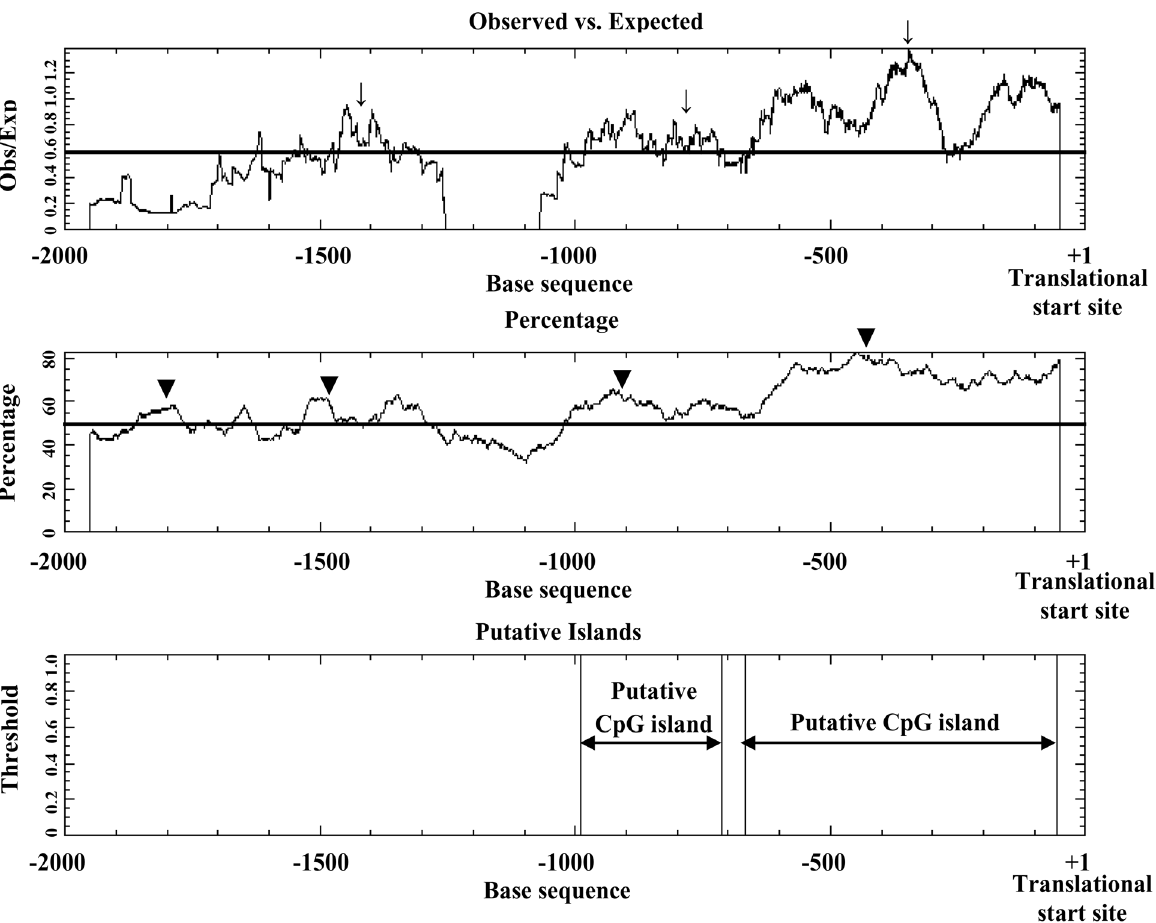
Figure 2. Identification of CpG island in the promoter region of ck b gene by using CpGPlot. Regions with $ 200 bp of nucleotides, observed/expected ratio . 0.6 ( Q ) and GC% . 50% ( . ) were identified as putative CpG islands.